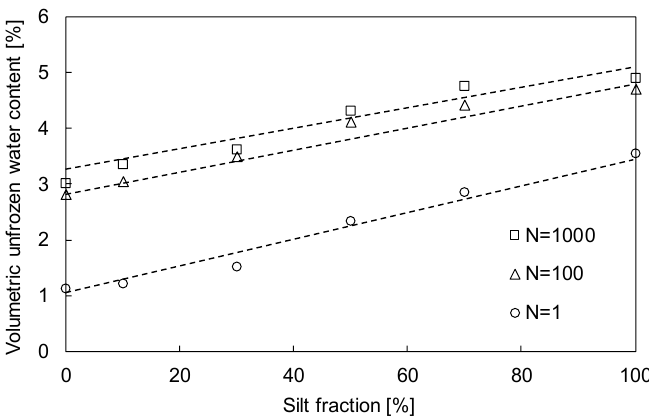
Figure 8. Volumetric unfrozen water content of sand–silt mixtures subjected to N = 1, 100, and 1000 according to SF.